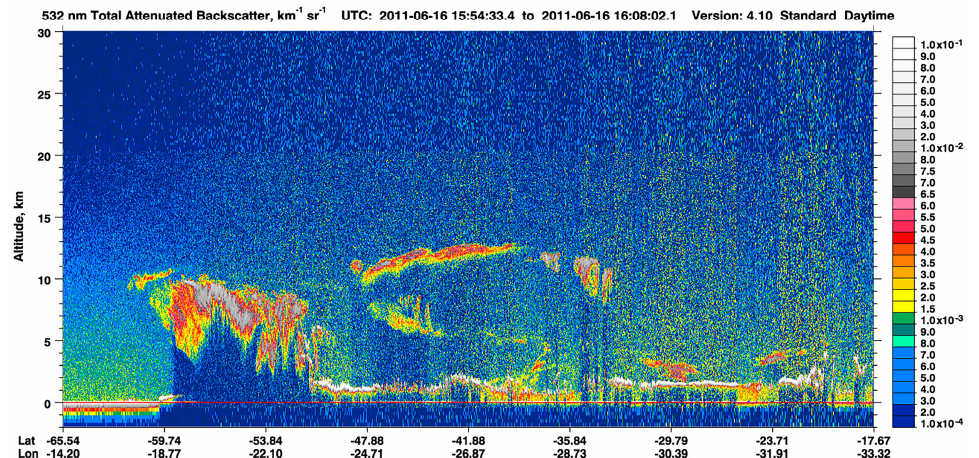
Figure 3. Image of CALIOP total attenuated backscatter at 532 nm from 15:54–16:08 UTC on 16 June 2011 for the Puyehue–Cordón Caulle eruption [37].